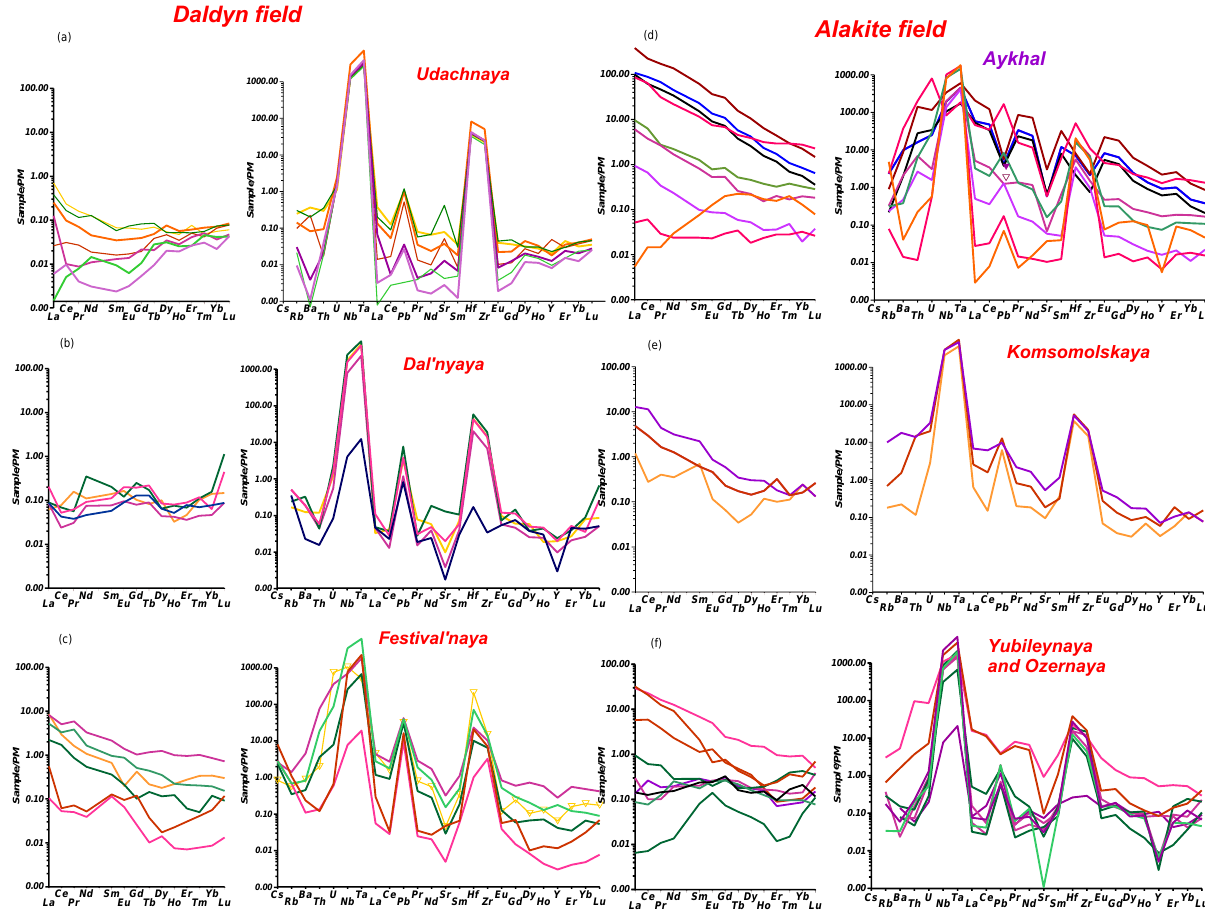
Figure 12. (a) REE and trace element spider diagrams for ilmenites from heavy mineral separates from Daldyn field kimberlites ( a Udachnaya, b Dalnyaya and c Festival’naya pipes) and from Alakit field kimberlites ( d Aykhal, e Komsomolskaya, f Yubileinaya and Ozernaya